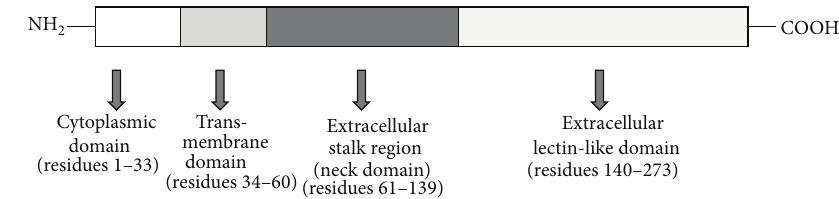
Figure 1: Schematic representation of LOX-1 structure. LOX-1 consists of four domains: a cytoplasmic N-terminal domain, a single transmembrane domain, an extracellular neck domain, and an extracellular lectin-like domain.